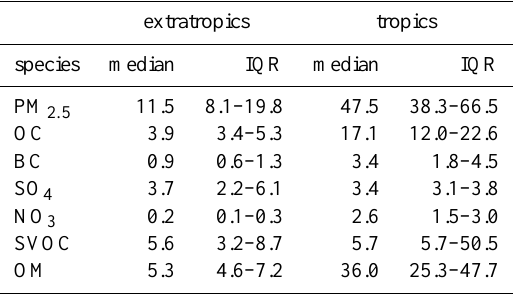
Table 5. Mass concentrations ( µ g/m 3 ) of PM 2 . 5 and species con- tributing to PM 2 . 5 (OC, BC, SO 4 , NO 3 , and SVOC) samples repre- sentative of the extratropics and the tropics of Southern Hemisphere Africa. Statistics are presented as median and interquartile range (IQR). OM is calculated as 1.4*OC in the extratropics, and 2.1*OC in the tropics (see discussion in